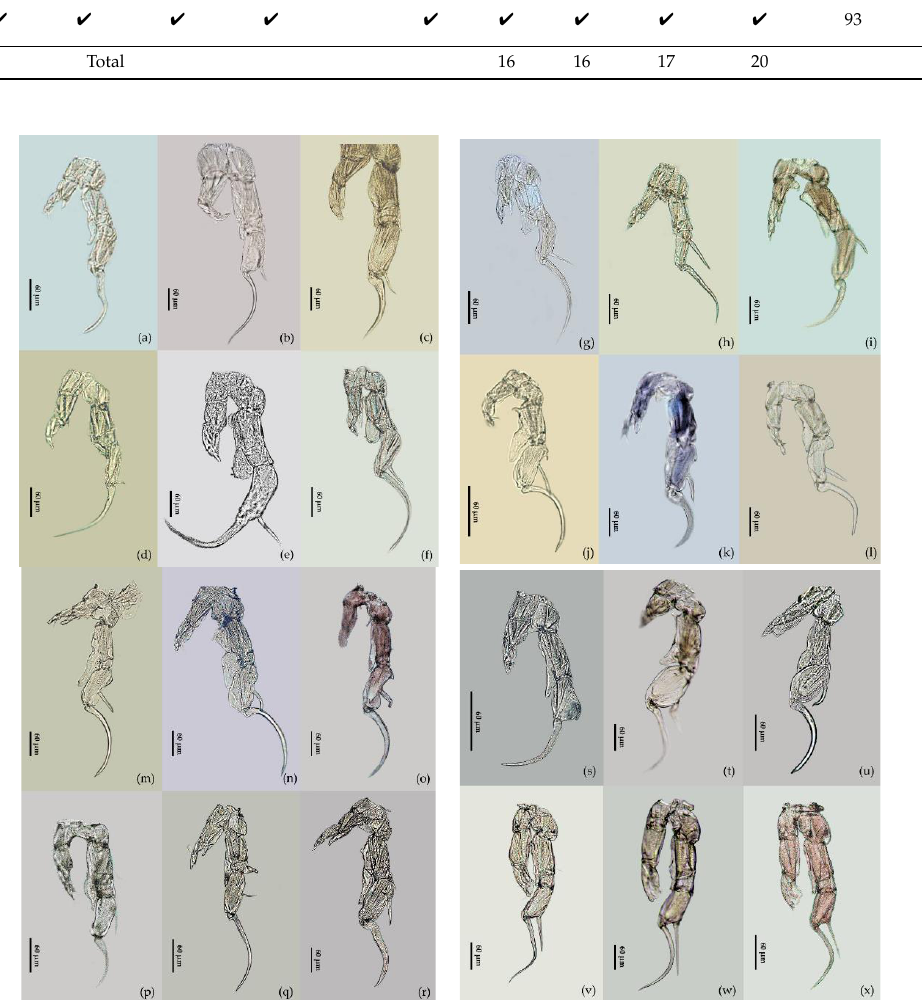
Figure 2. Photographs of the male leg 5 (P5) of diaptomid copepods which have been recorded in Cambodia: ( a ) Allodiaptomus raoi ; ( b ) Dentodiaptomus javanus ; ( c ) D. orientalis ; ( d ) Eodiaptomus draconisignivomi ; ( e ) E. phuphanensis ; ( f ) E. phuvongi ; ( g ) E. sanoamuangae ; ( h ) Heliodiaptomus elegans ; ( i ) H. phuthaiorum ; ( j ) Mongolodiaptomus botulifer ; ( k ) M. calcarus ; ( l ) M. dumonti ; ( m ) M. formosanus ; ( n ) M. malaindosinensis ; ( o ) M. mekongensis ; ( p ) Neodiaptomus laii ; ( q ) N. yangtsekiangensis ; ( r ) Vietodiaptomus blachei ; ( s ) Phyllodiaptomus (C.) praedictus ; ( t ) P. (P.) roietensis ; ( u ) P. (P.) sp.; ( v ) Tropodiaptomus oryzanus ; ( w ) T. sp . ; and ( x ) T. vicinus .